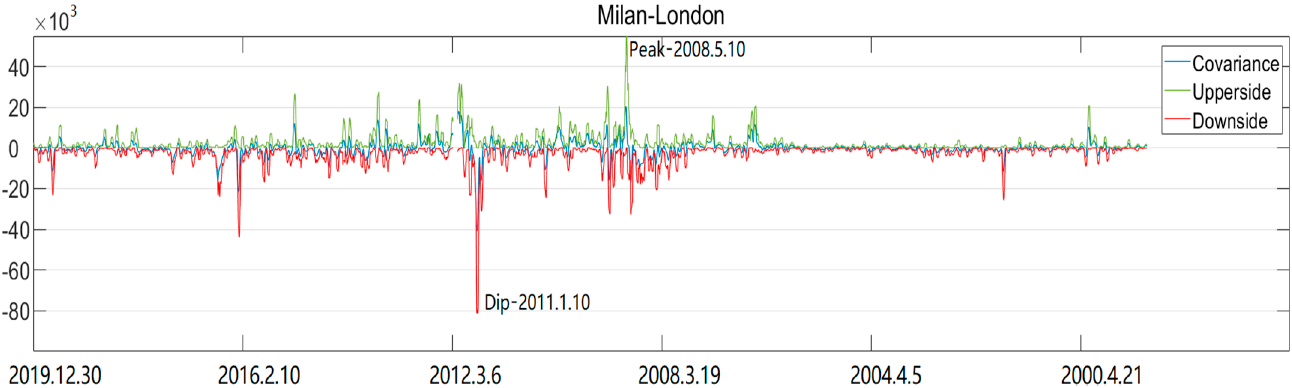
Figure 1. Bi ‐ weekly/semi ‐ covariances between gold price and Shanghai Index China from the year 2019 back to 1999.